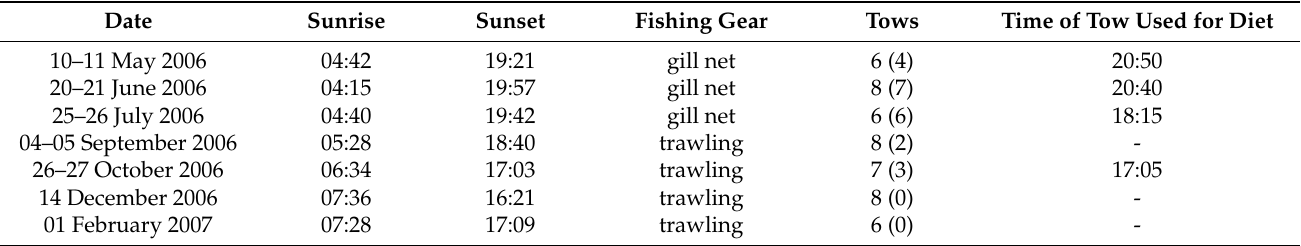
Figure 1. Map of the study area in the Gulf of Trieste (northeastern Adriatic Sea), with the ending positions of the fishing tows ( • ) (black dots) used to describe both sardine diet and mesozooplankton in the field. Table 1. Sampling information: date; sunrise and sunset time at each sampling day; fishing gear used; number of performed tows during the 24 h cycle of sampling and in brackets the number of tows with at least 20 sardines. Time is expressed as (GMT + 1).